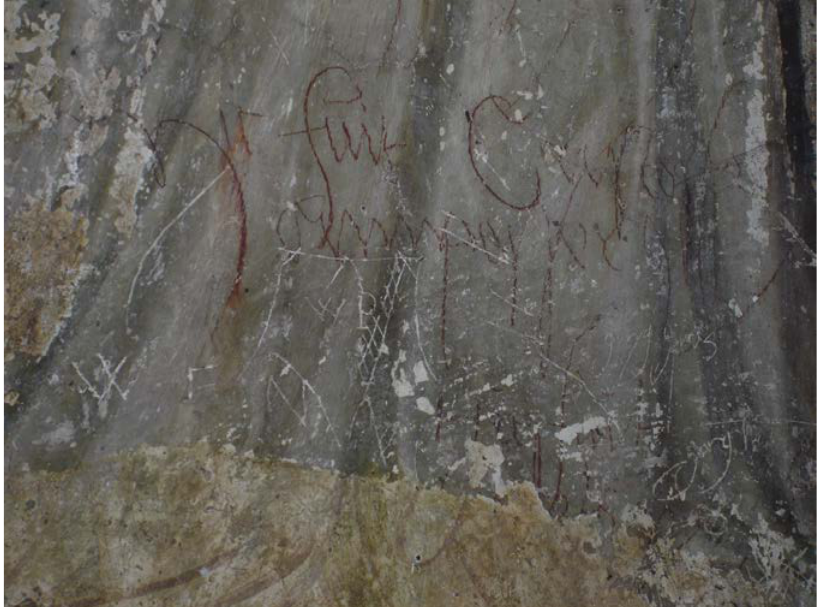
Figure 9 – Several graffiti from Hall in Tirol show the picture of gallows with pending letters (initials?). This example with ladder can be found in the choir paintings of the Church of Our Saviour. Photo by Romedio Schmitz-Esser. Courtesy of the